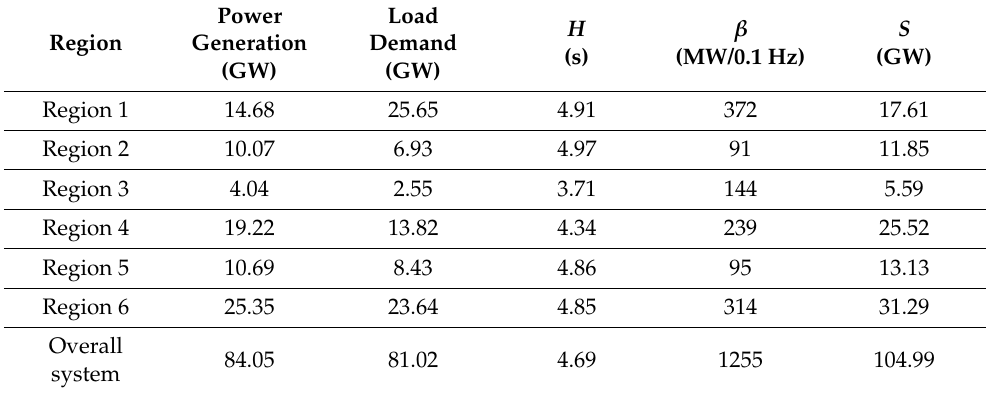
Table 1. Conventional SGs characteristics in Korean electric power system.